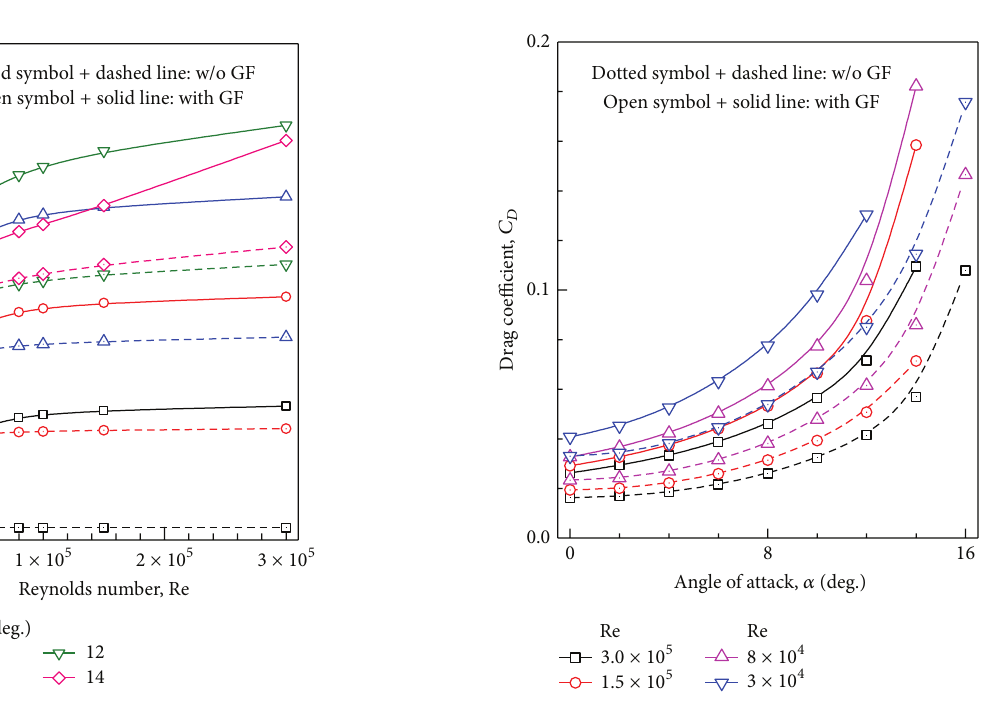
Figure 4: Variation of 𝐶 𝐿 with Reynolds number for the airfoil without and with GF.